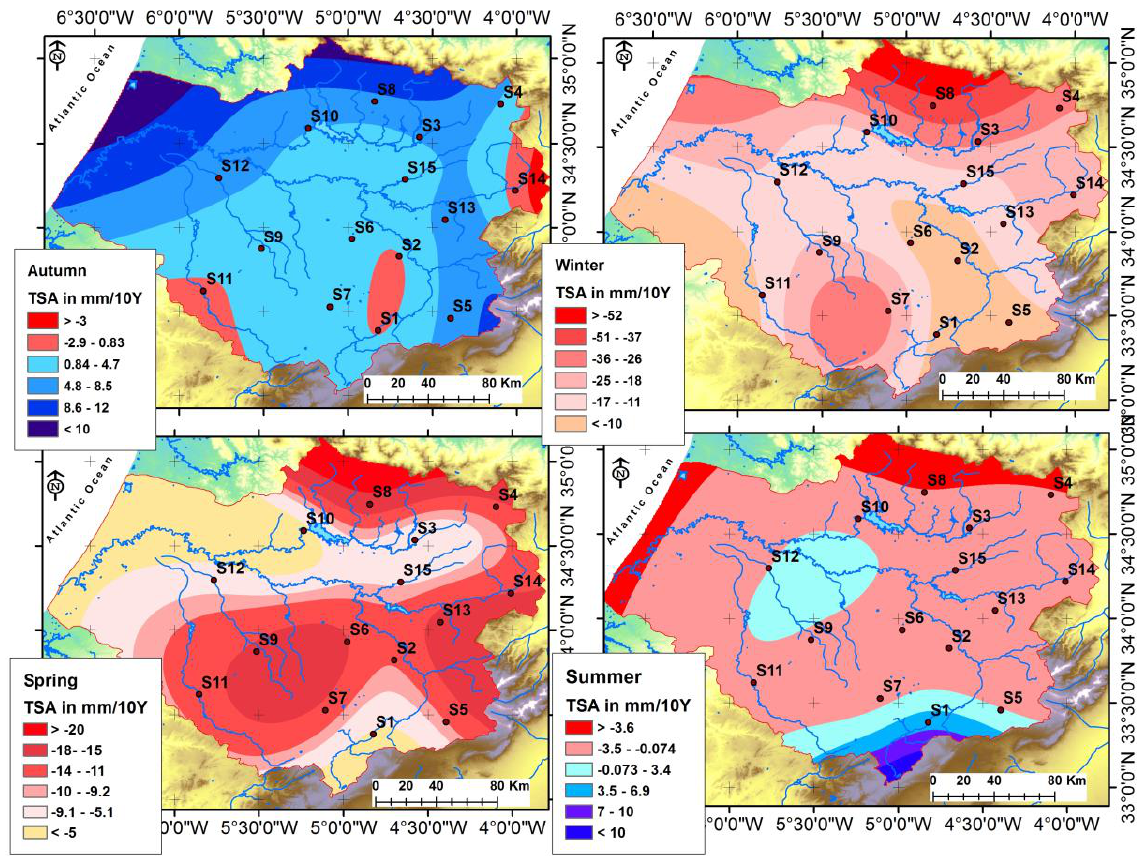
Figure 5. Theil–Sen Slope approach (TSA) for seasonal rainfall expressed in mm/10